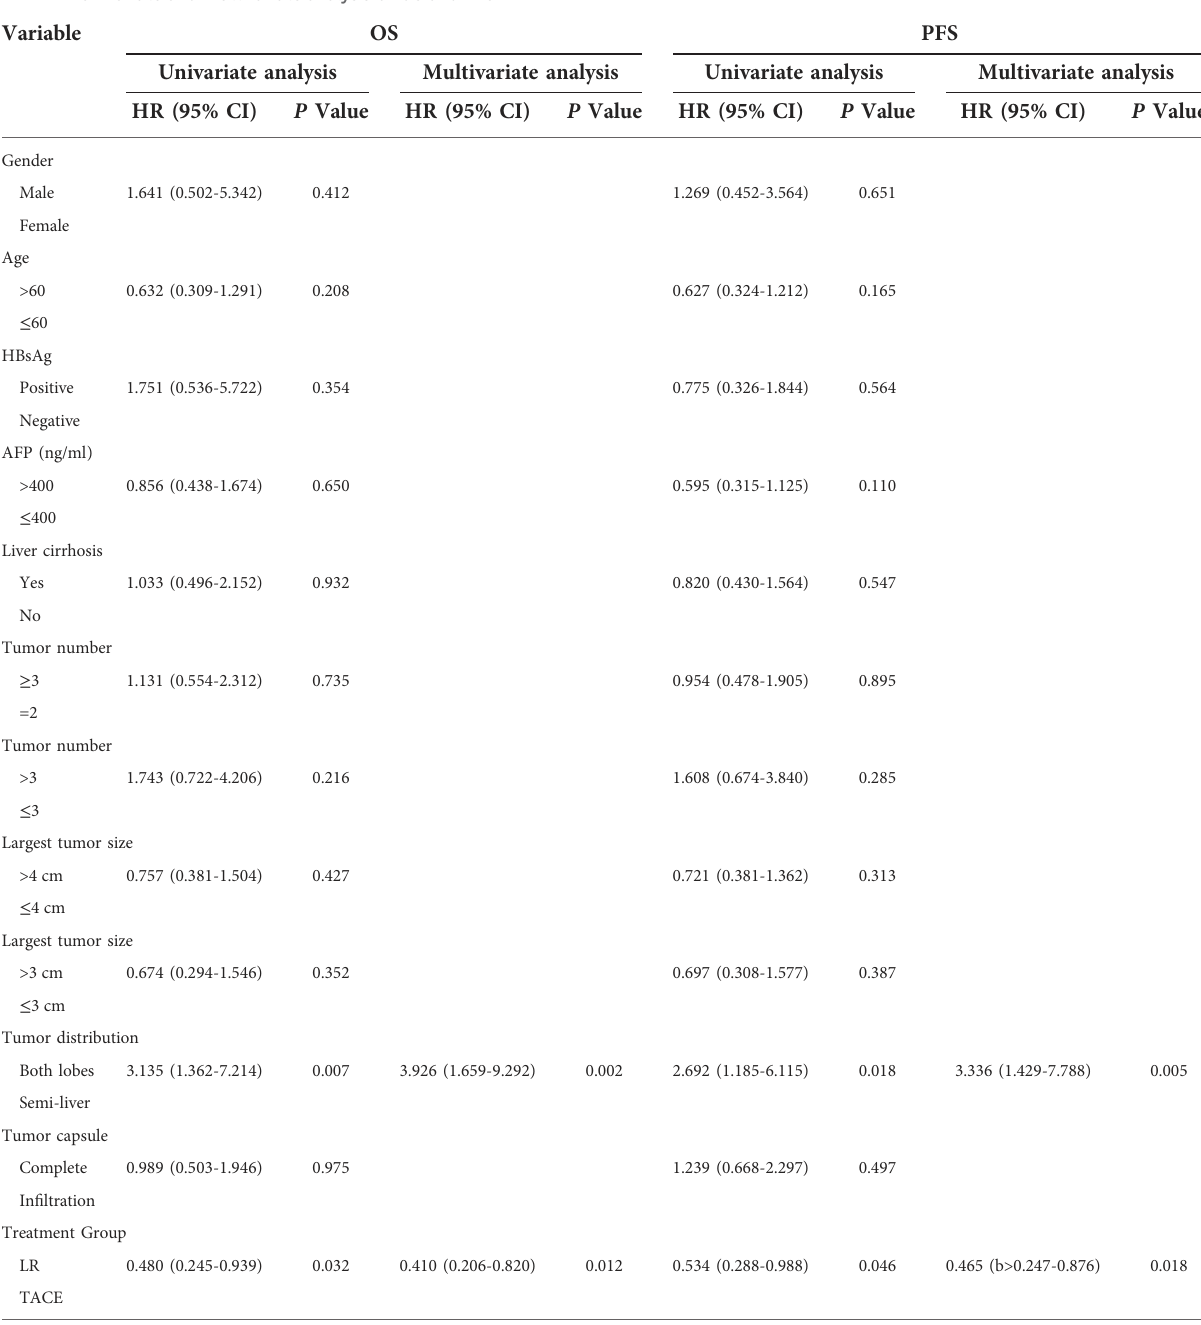
TABLE 4 Univariate and multivariate analysis of OS and